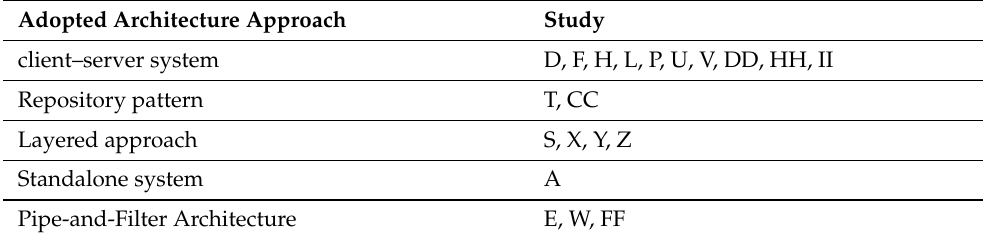
Table 7. Overview of architectures of OST